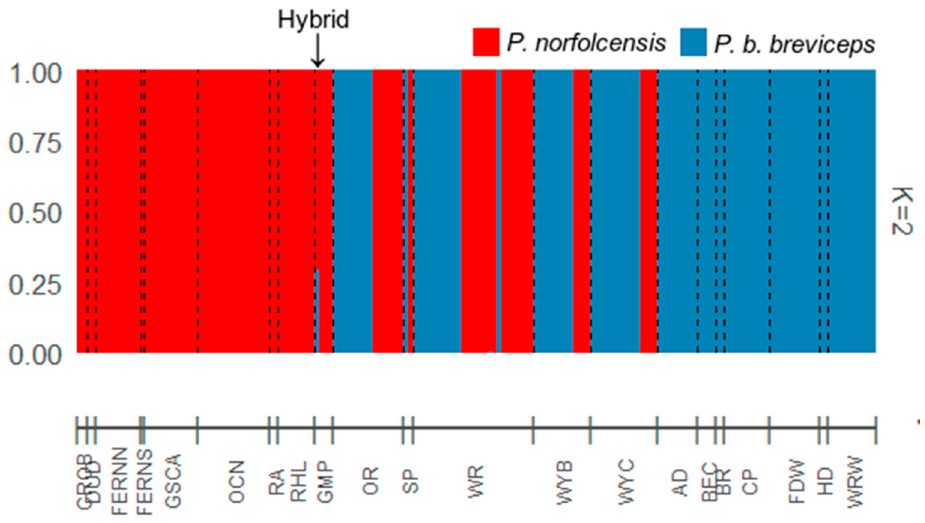
Figure 6. STRUCTURE admixture results using K = 2 and 10,111 SNPs. A total of 178 of the 179 Petaurus individuals were assigned “pure” to a cluster ( P. norfolcensis or P. b. breviceps species), with one individual displaying admixture (hybrid P. norfolcensis × P. b. breviceps ). Locations are listed along the bar on the x axis (refer to Figure 2 for more information).